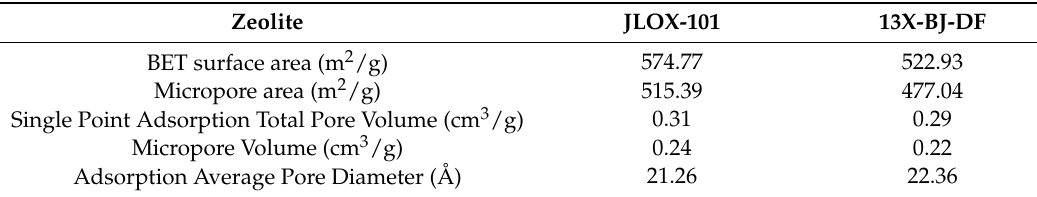
Figure 4. XRD pattern of three different types of zeolites: UOP-13X, Beijing-DF-13X and JLOX101-LiX. Table 2. BET adsorption results of JLOX-101 and 13X-BJ-DF.